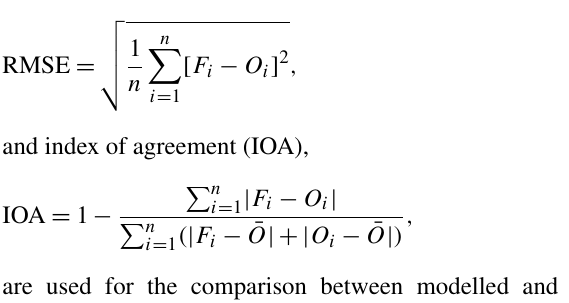
servational data. The root mean square error